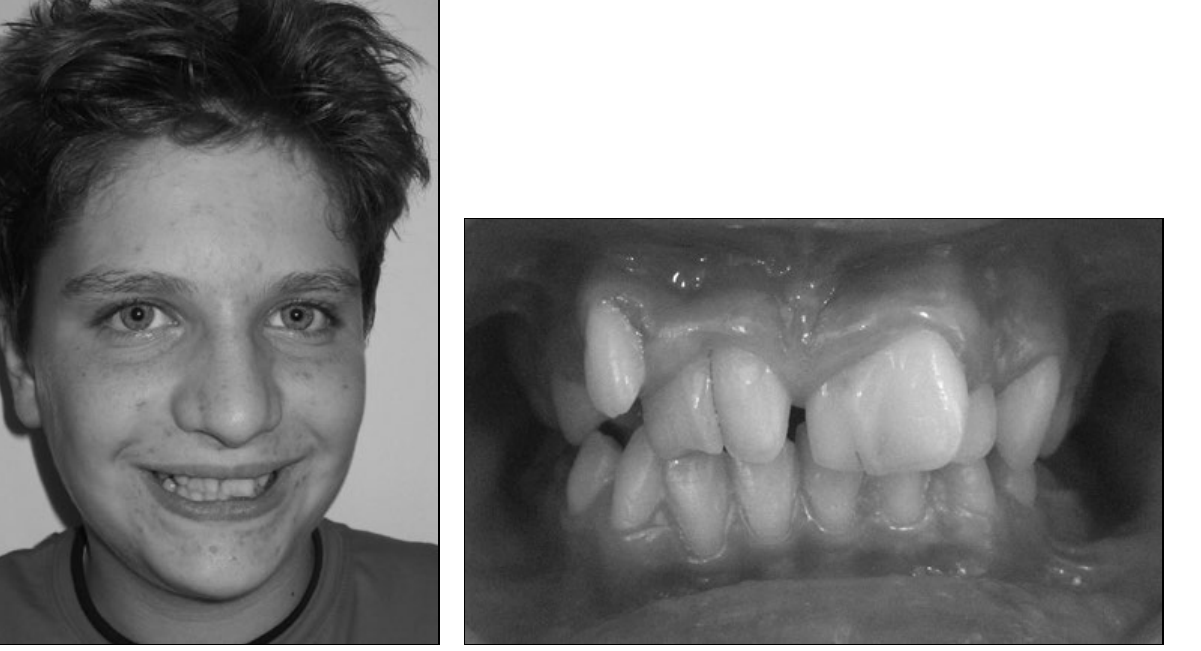
Figure 2. Initial intra-oral photograph revealing the 'double' incisors.